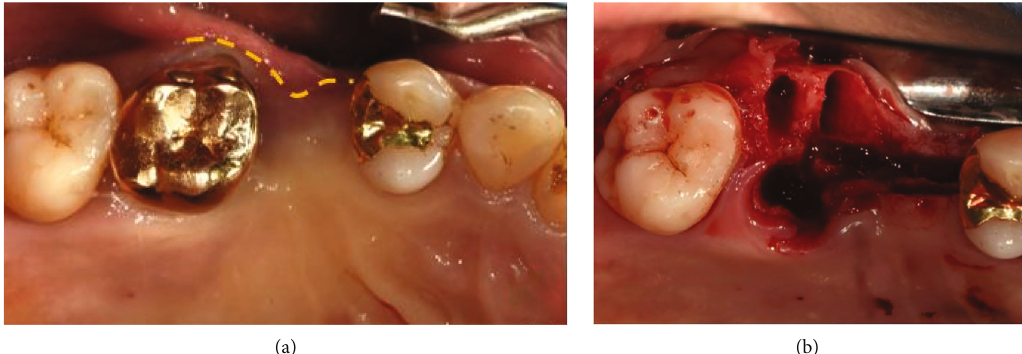
Figure 2: Intraoral views of alveolar ridge split technique with ridge preservation (Case 1). (a) Pre-operative clinical gingiva. (b) Alveolar bone was split and expanded with chisel.